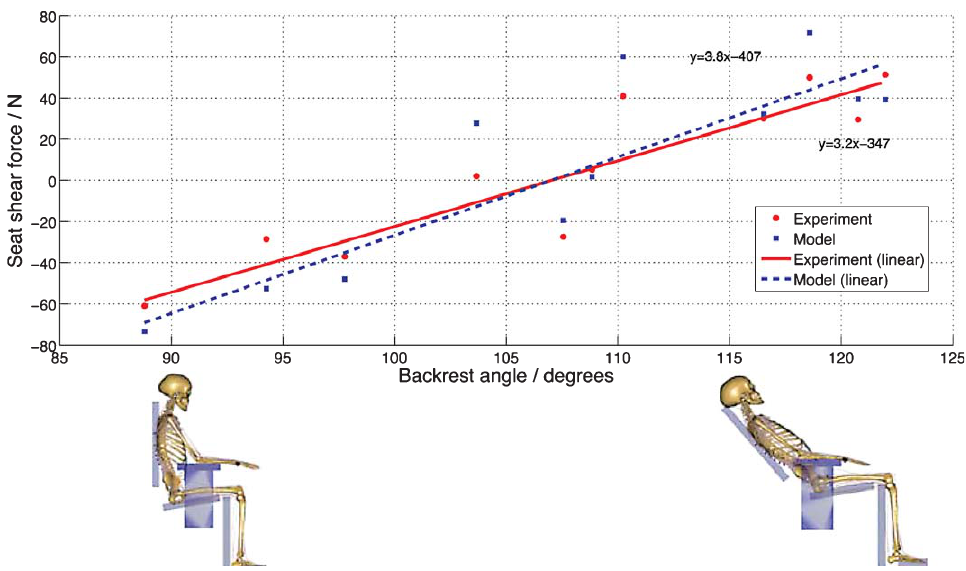
Fig. 3. The effect on the seat shear force from varying the backrest angle. The data show clear correspondence and a trend towards higher seat shear force when the backrest is